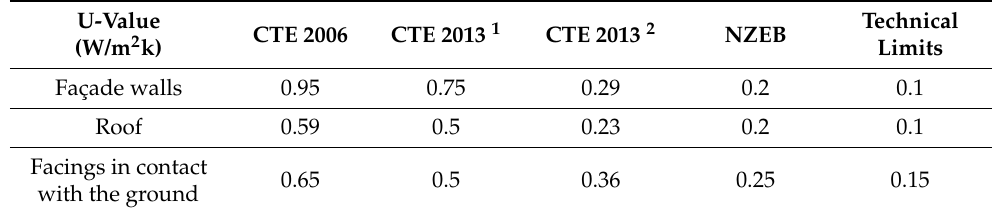
Table 2. Thermal transmittance in Spain’s C2 zone